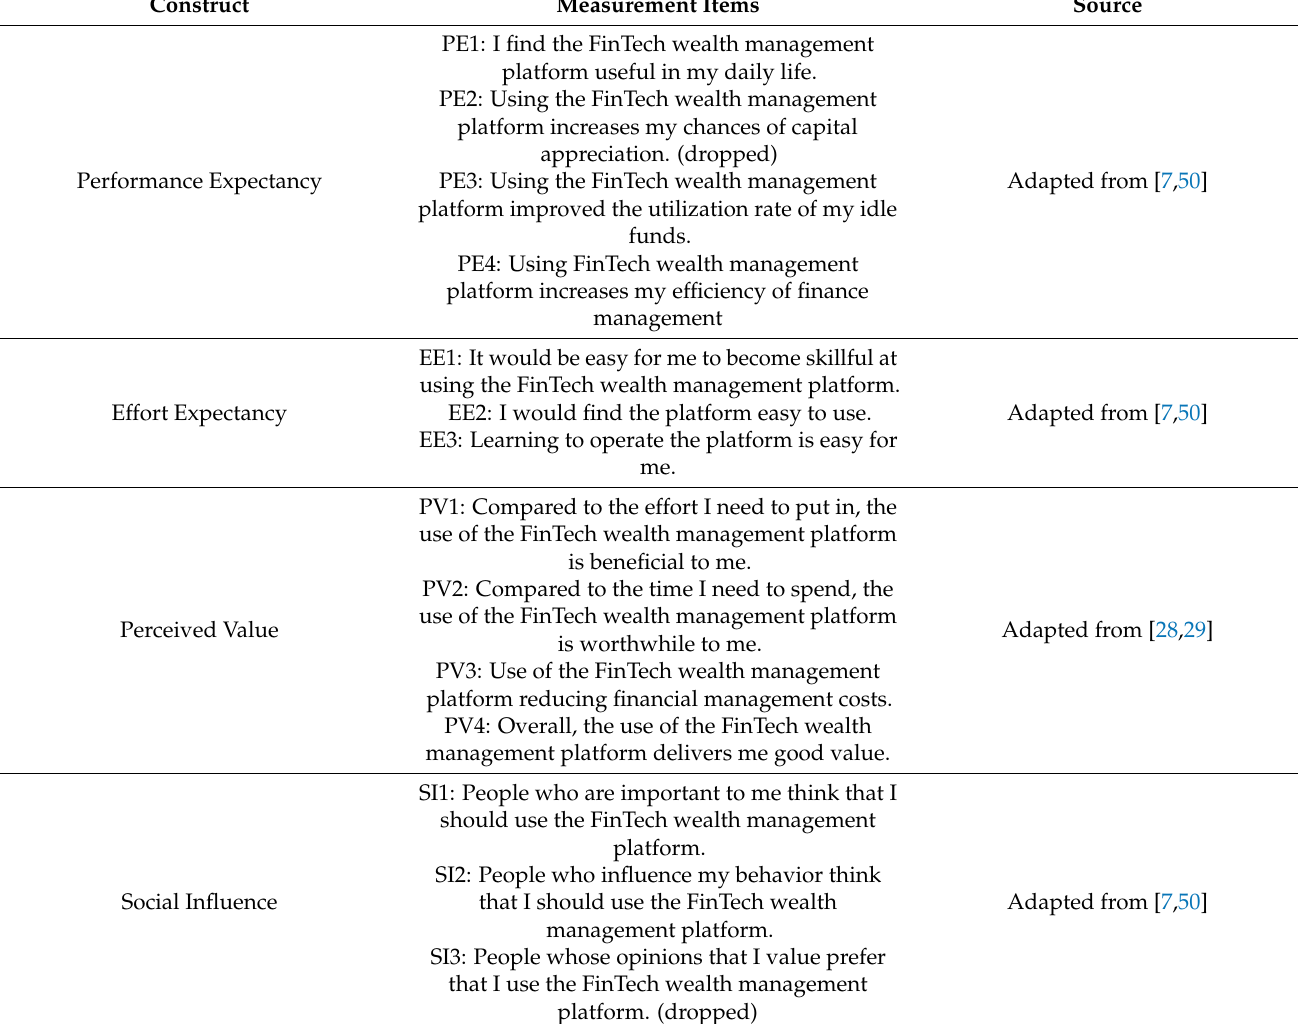
Table A1. Measurement items and